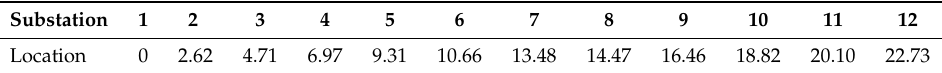
Table 4. Location of substations.